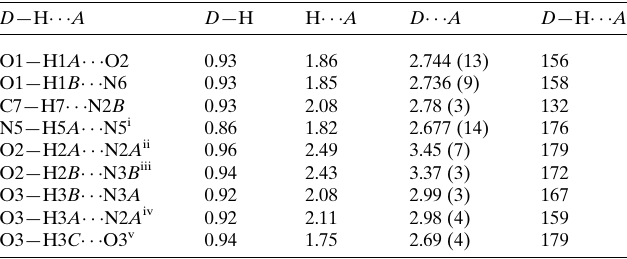
Table 1 Hydrogen-bond geometry (A˚ , (cid:3) ).